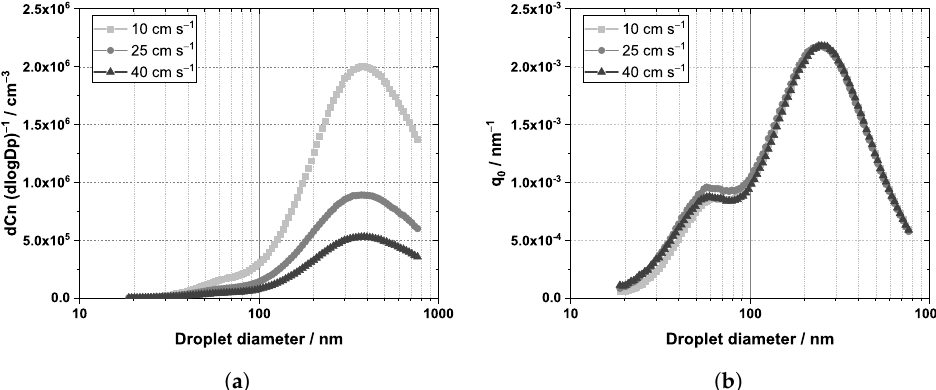
Figure 3. ( a ) Number concentration and ( b ) differential number distribution of the raw gas for filtration velocities of 10, 25 and 40cms − 1 . The differential pressure across the nebulizer was held constant at